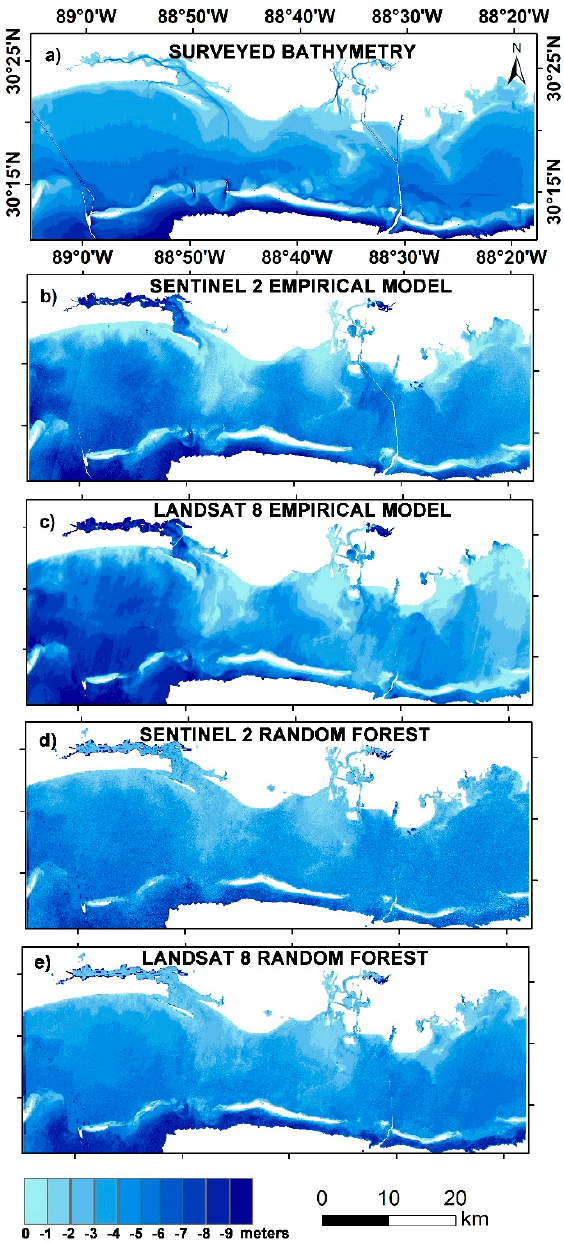
Figure 7. Bathymetric maps of Mobile Bay, Mississippi: ( a ) surveyed bathymetry; ( b ) Sentinel-2 derived bathymetry from empirical approach; ( c ) Landsat-8 derived bathymetry from empirical approach; ( d ) Sentinel-2 derived bathymetry from random forest; ( e ) Landsat-8 derived bathymetry from random forest.